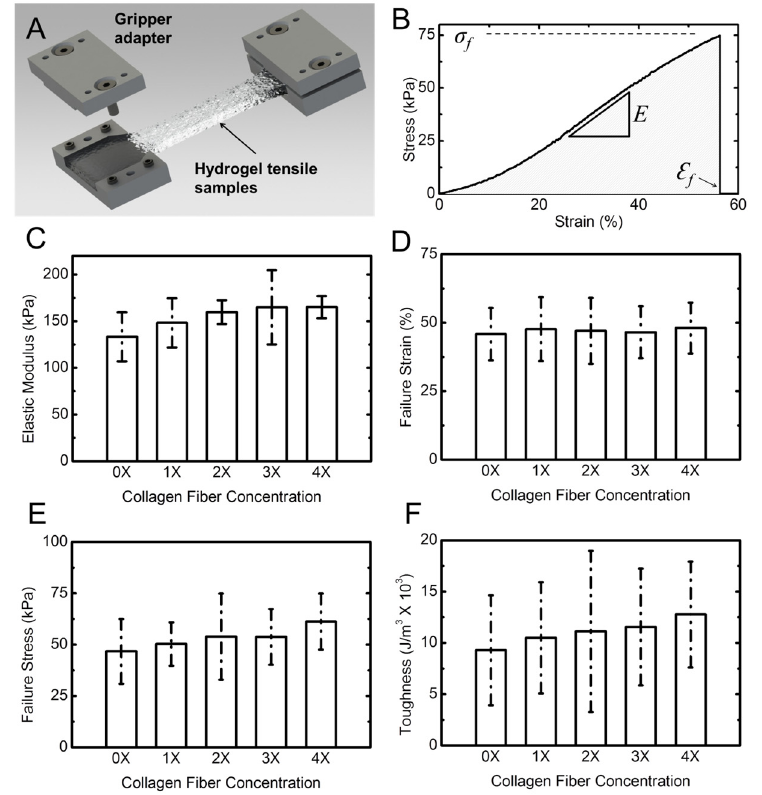
Figure 5. Tensile properties of hydrogel samples. ( A ) Schematic shows the dog-bone shaped hydrogel sample gripped using costume-designed gripper adaptor; ( B ) A typical stress-strain response from a hydrogel sample. The slope of the linear section of the response was used to extract the elastic (Young’s) modulus of the hydrogel specimen; ( C ) The Young’s modulus; ( D ) failure strain; ( E ) failure stress; and ( F ) toughness of hydrogel vs. collagen concentration. Error bars represent standard deviation (SD) for five samples for each